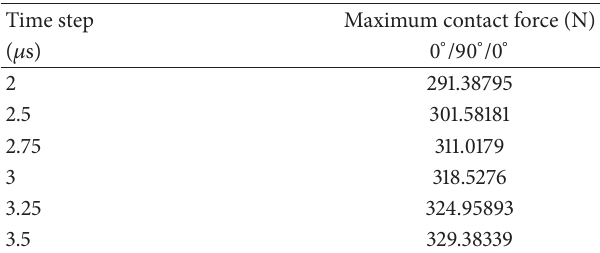
Table 2: Convergence study for time